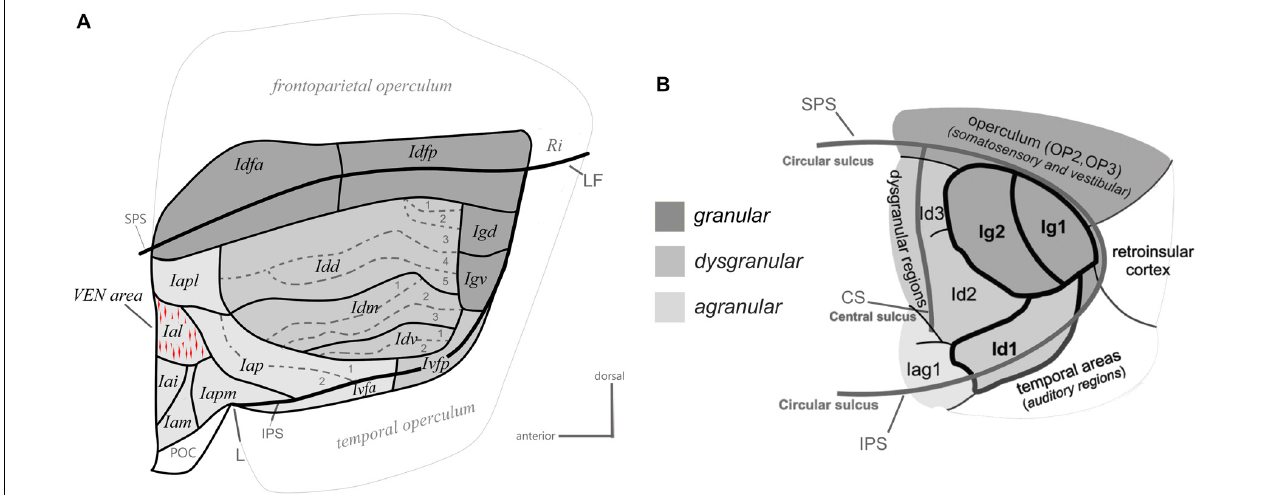
FIGURE 2 | Architectonic parcellation of the insular cortex in the macaque monkey (A) and human (B) . Both panels present a schematic flat map view of the insula, adapted with permission from Kurth et al. (2010a) and Evrard et al. (2014). The human flat map shows only the posterior lobule of the insula. In both maps, the granular, dysgranular, and agranular sectors are represented by different shades of gray (see scale), with non-insular regions shaded a lighter gray than the agranular insula. See the main text for a full